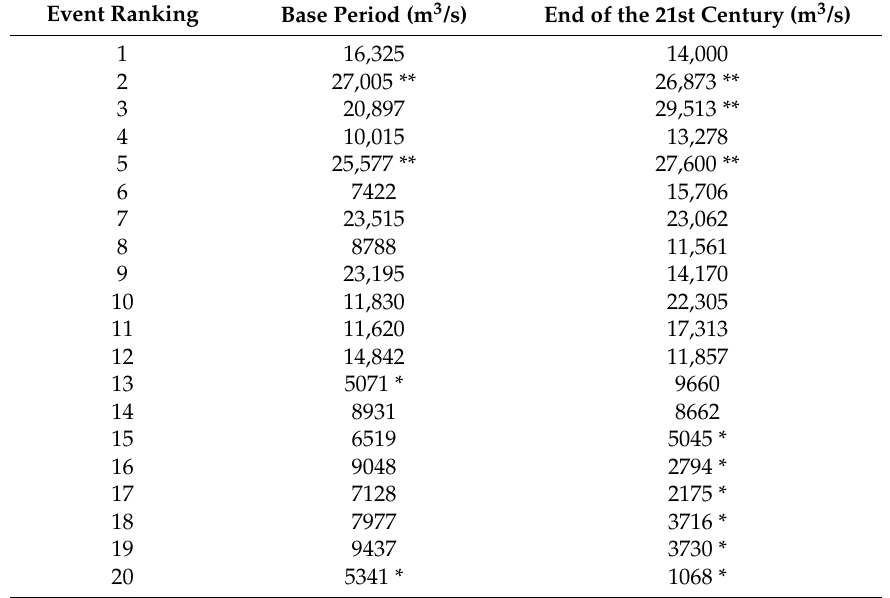
Table 1. Simulation results of peak flow discharge of each of the top 20 typhoons during the two periods at the Chunyun Bridge. Event Ranking Base Period (m 3